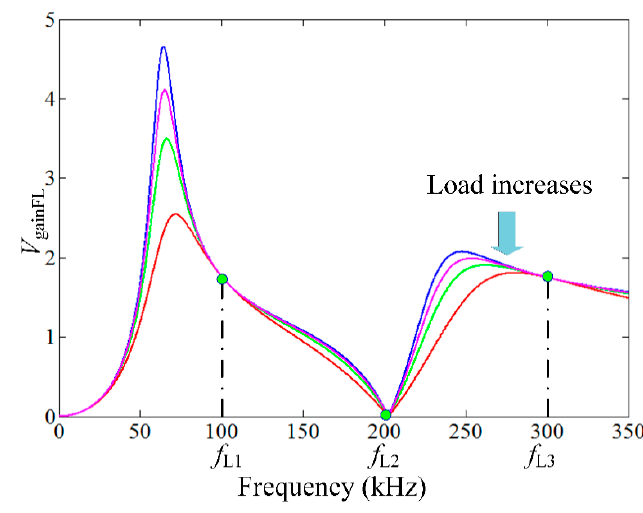
Figure 3. DC voltage gain curves of the LCLCL circuit.